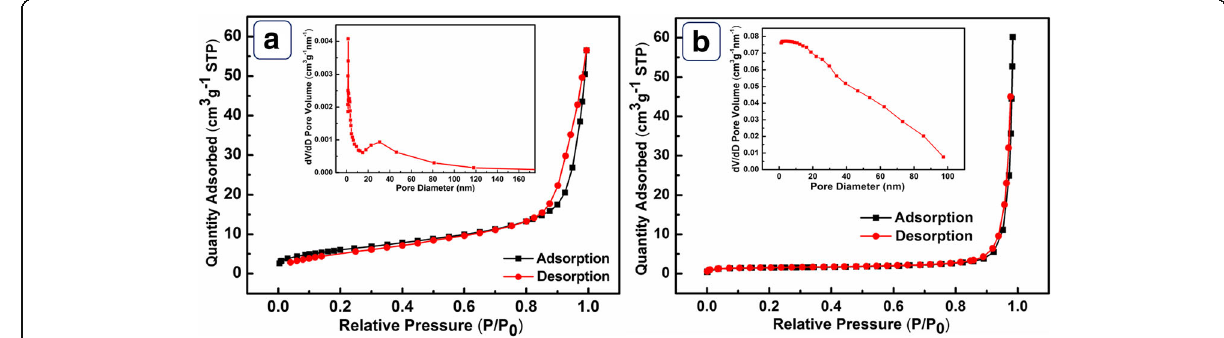
Fig. 4 N 2 adsorption-desorption isotherms of a NiO HPA and b NiO BHPA. Inset of a and b are the corresponding pore size distribution,